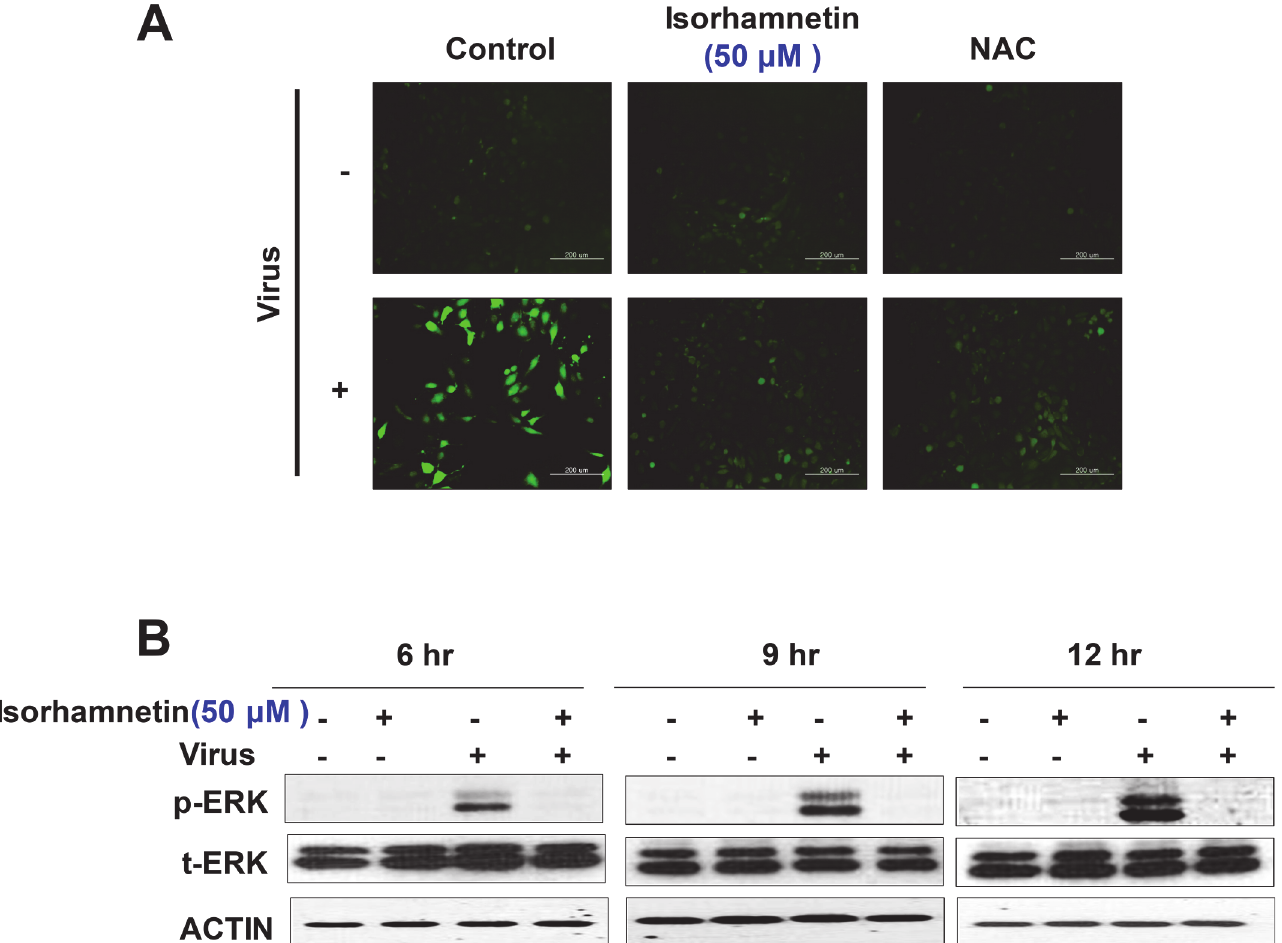
Fig 5. Effect of isorhamnetin on the inhibition of the influenza virus-induced ROS generation and ERK phosphorylation. (A) After influenza virus infection and isorhamnetin treatment, ROS generation was measured using ROS fluorescent probe, H 2 DCFDA. Scale bar = 200 μ m. (B) Western blot analysis for phosphorylation of ERK. After influenza A virus infection and isorhamnetin treatment, we checked the phosphorylation level of ERK in a time- dependent manner (6 hr, 9 hr, and 12 hr) after virus infection